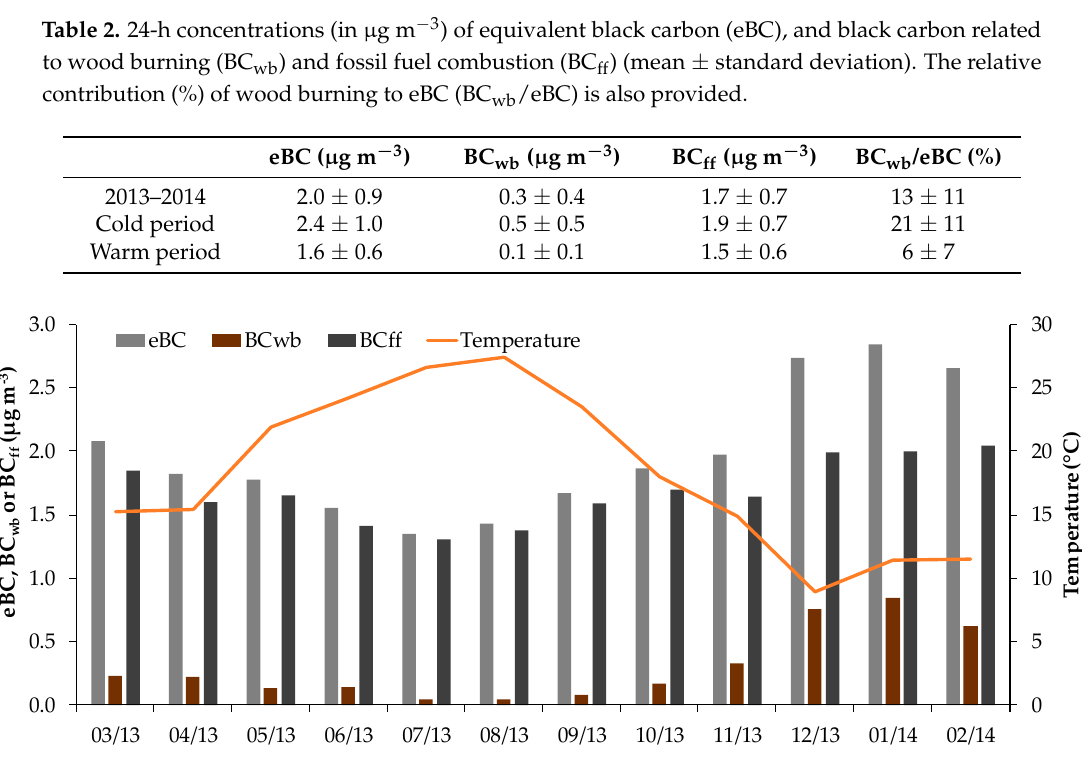
Figure 3. Mean monthly concentrations of eBC, BC wb and BC ff and the corresponding ambient temperatures.